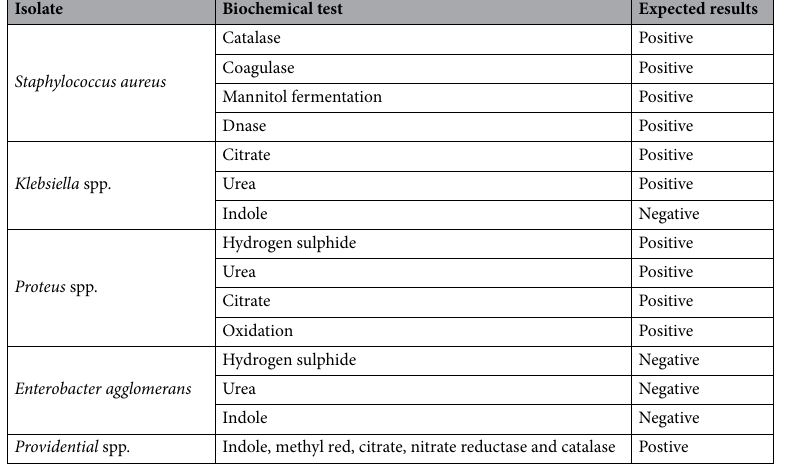
Providential Table 1. Biochemical tests for Identification of bacterial pathogens.